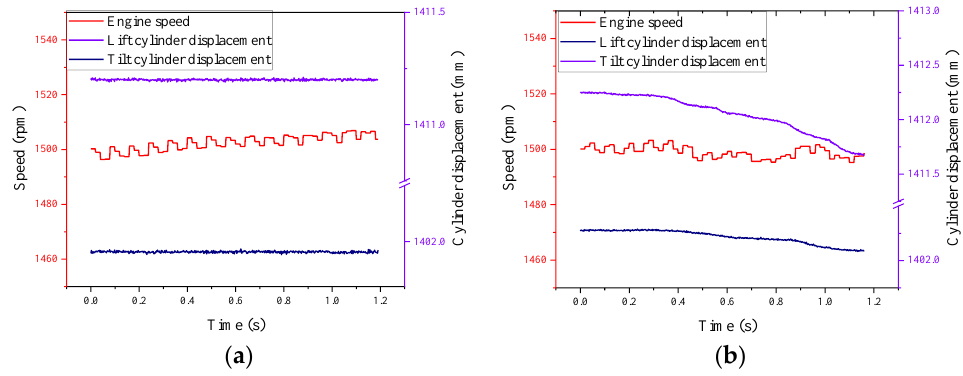
Figure 3. Engine speed and cylinder displacement. ( a ) Gravel; ( b )